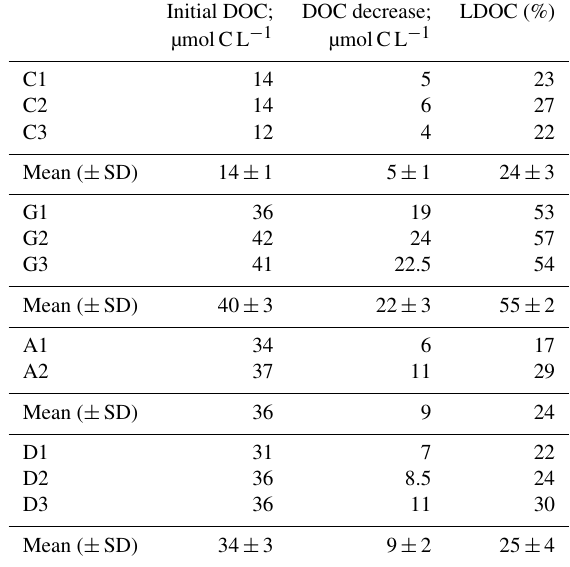
Table 2. Initial dissolved organic carbon concentration and its de- crease and contribution to the initial DOC stocks (expressed as a percentage of labile dissolved organic carbon, LDOC). In the con- trol treatment, LDOC was calculated between T 5 . 7 and T final